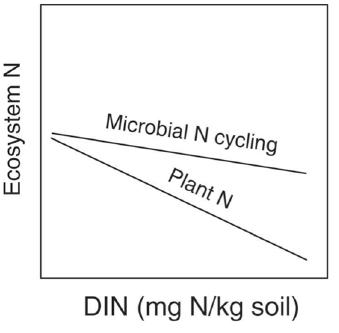
(Figure 2A). The two remaining rainfall events were small enough that they would not have caused significant leaching.